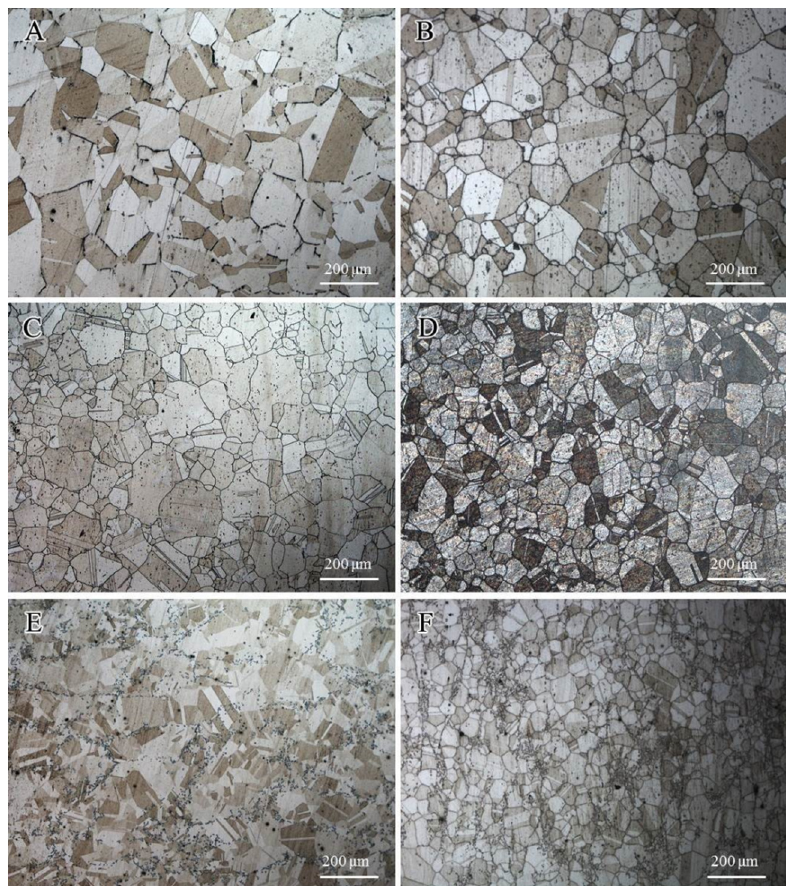
Figure 9. Optical micrographs of the three groups of HR3C alloys before and after steam oxidation at 650 °C for 0 h and 500 h: ( A , B ) commercial HR3C alloy, ( C , D ) 1#HR3C alloy, and ( E , F ) 2#HR3C alloy.